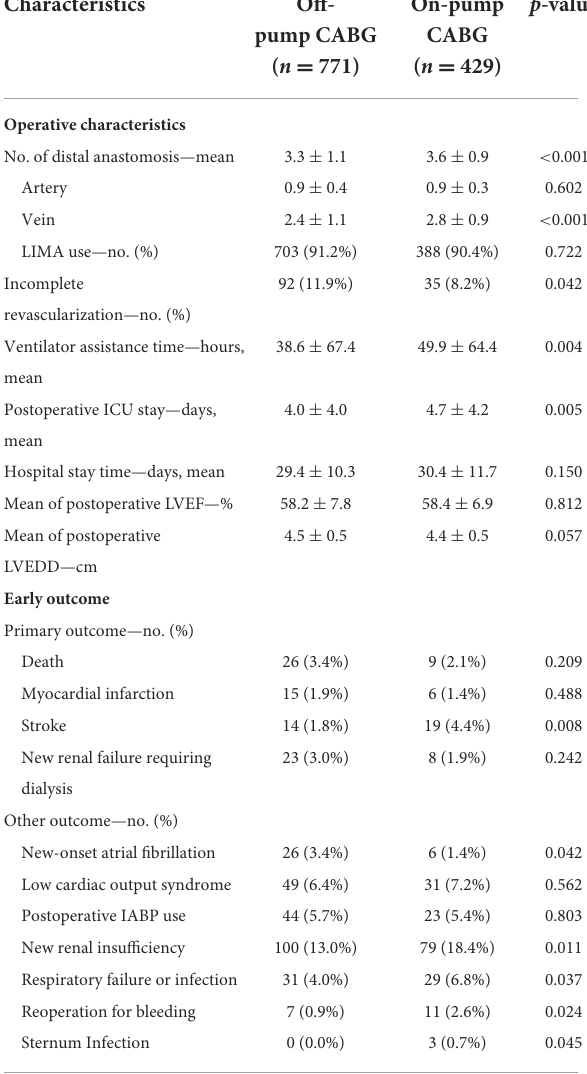
TABLE 2 Operative characteristics and early outcome of the patients before matching. Characteristics Off-